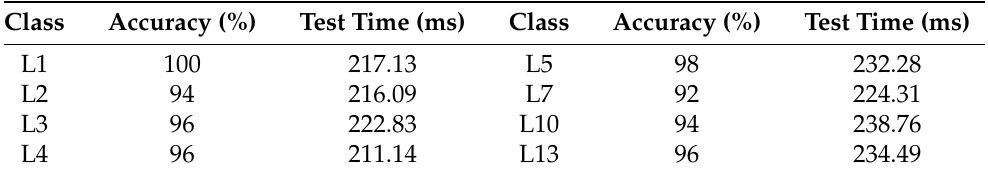
Table 4. The performance of the experimental